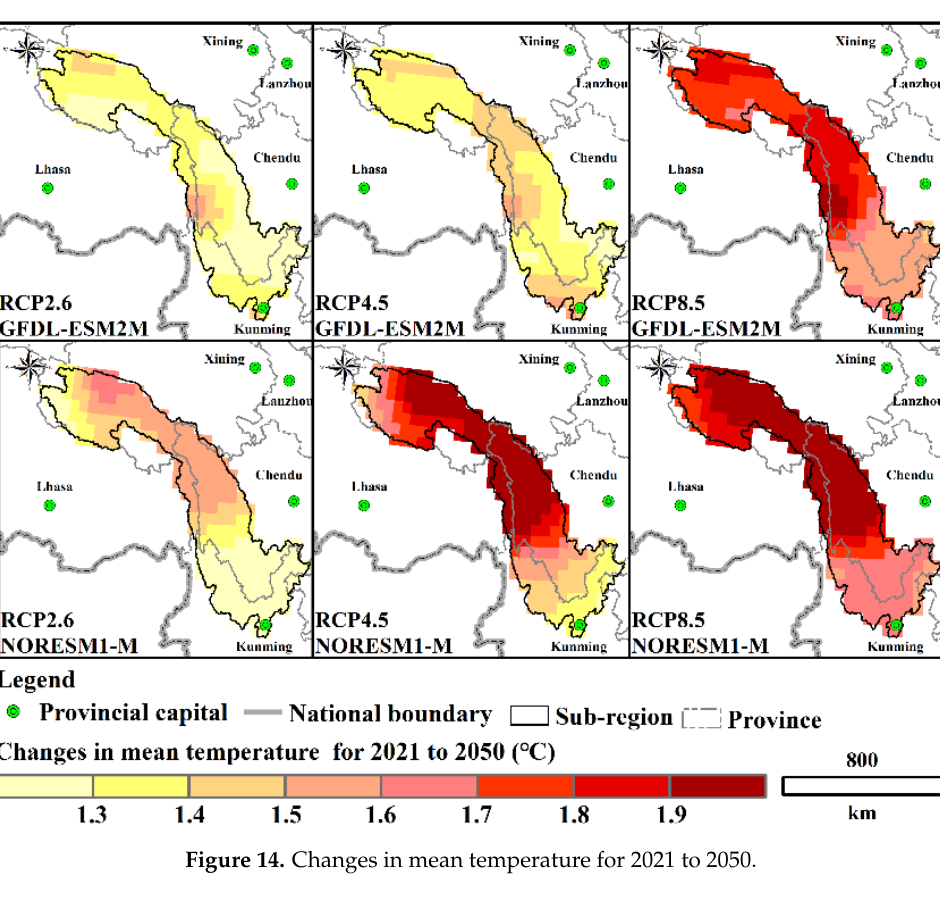
Figure 14. Changes in mean temperature for 2021 to 2050.